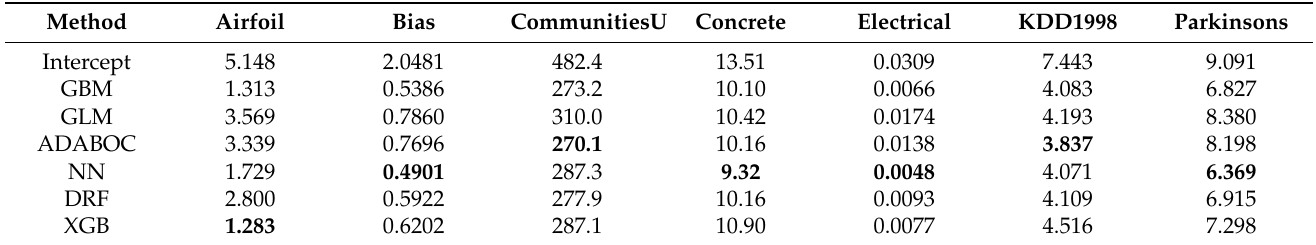
Table 4. MAE results by